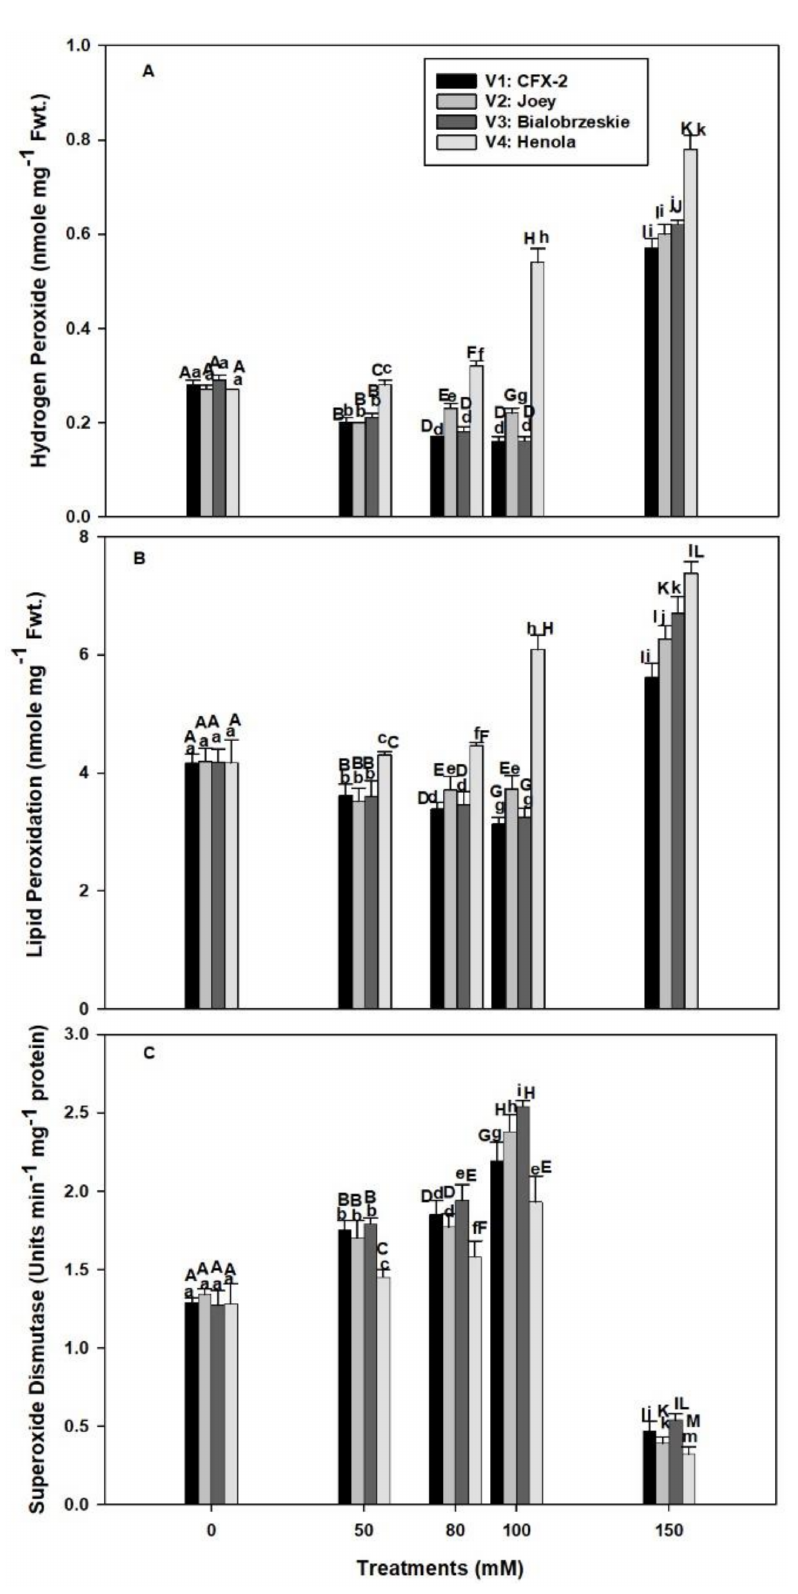
Figure 2. Effects of NaCl on IH root H 2 O 2 concentration ( A ), lipid peroxidation ( B ), and SOD specific activity ( C ). Vertical bars represent SE. Different capital letters indicate significant differences among the varieties and lower case letters represent significant treatment